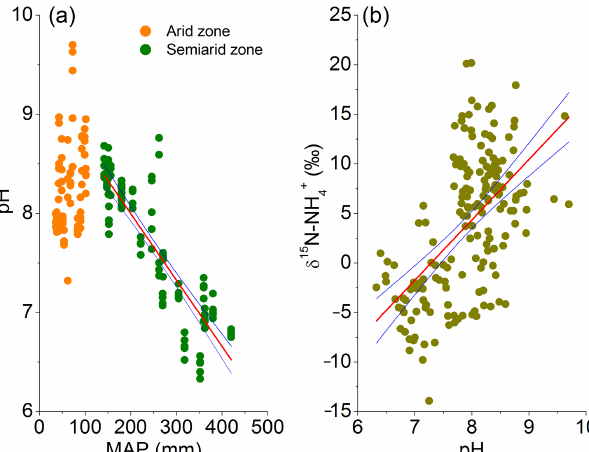
Figure 6. Soil pH and the relationship with δ 15 N of soil NH + different patterns of soil pH were observed above and below the threshold at MAP of about 100mm; data were derived from Wang et al. (2014). There was a positive correlation between δ 15 N of soil NH + and pH across the transect. The significant ( P< 0 . 05) trend 4 is shown with a regression line (red) and 95% confidence intervals (blue). At each site n =